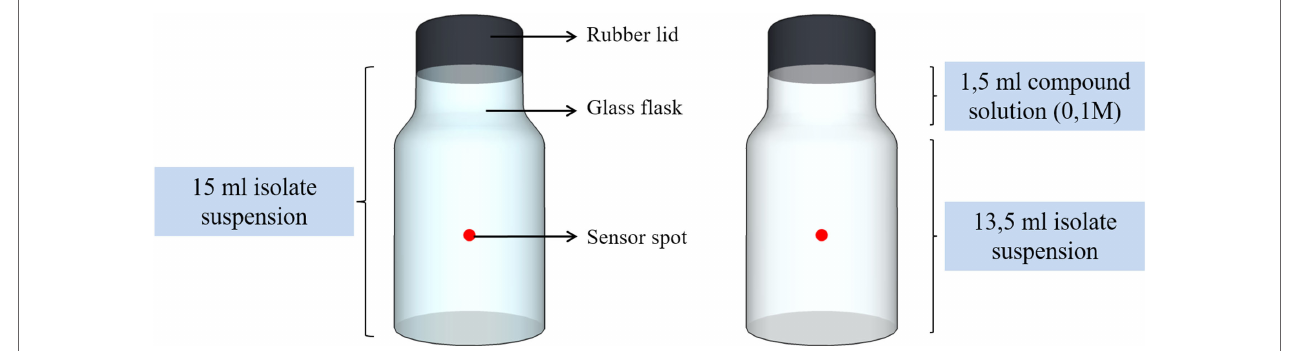
FigUre 1 | Glass flasks with oxygen sensor spots attached in the inner wall of the